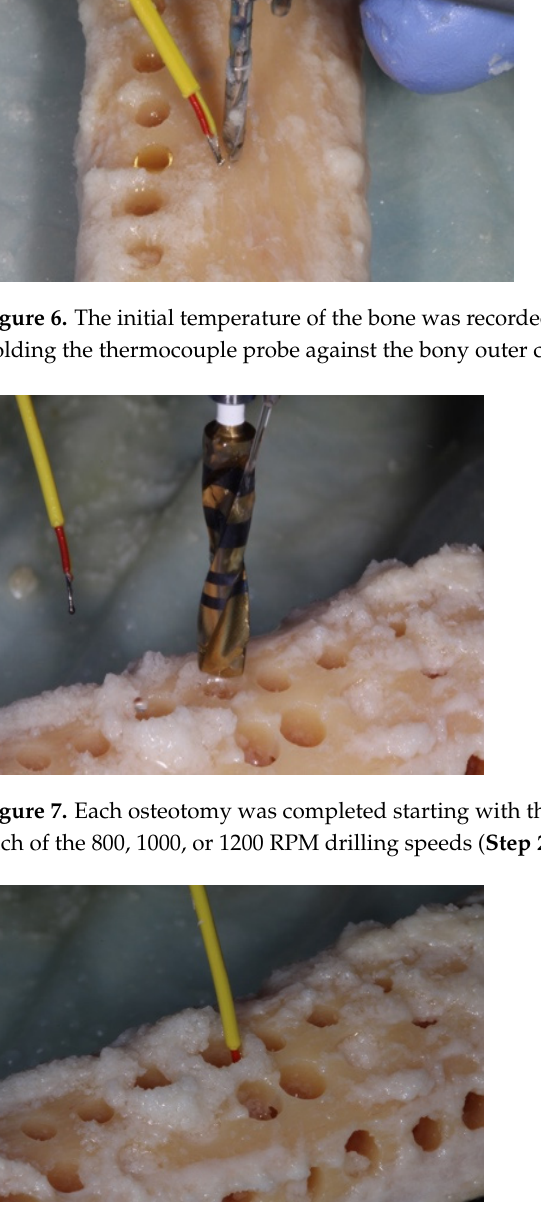
Figure 6. The initial temperature of the bone was recorded with the use of the K-Type thermocou- ple holding the thermocouple probe against the bony outer cortical layer ( Step 1 ). Each osteotomy was completed starting with the pilot drill with external irrigation at each of the 800, 1000, or 1200 RPM drilling speeds ( Step 2 ), (Figure 7).